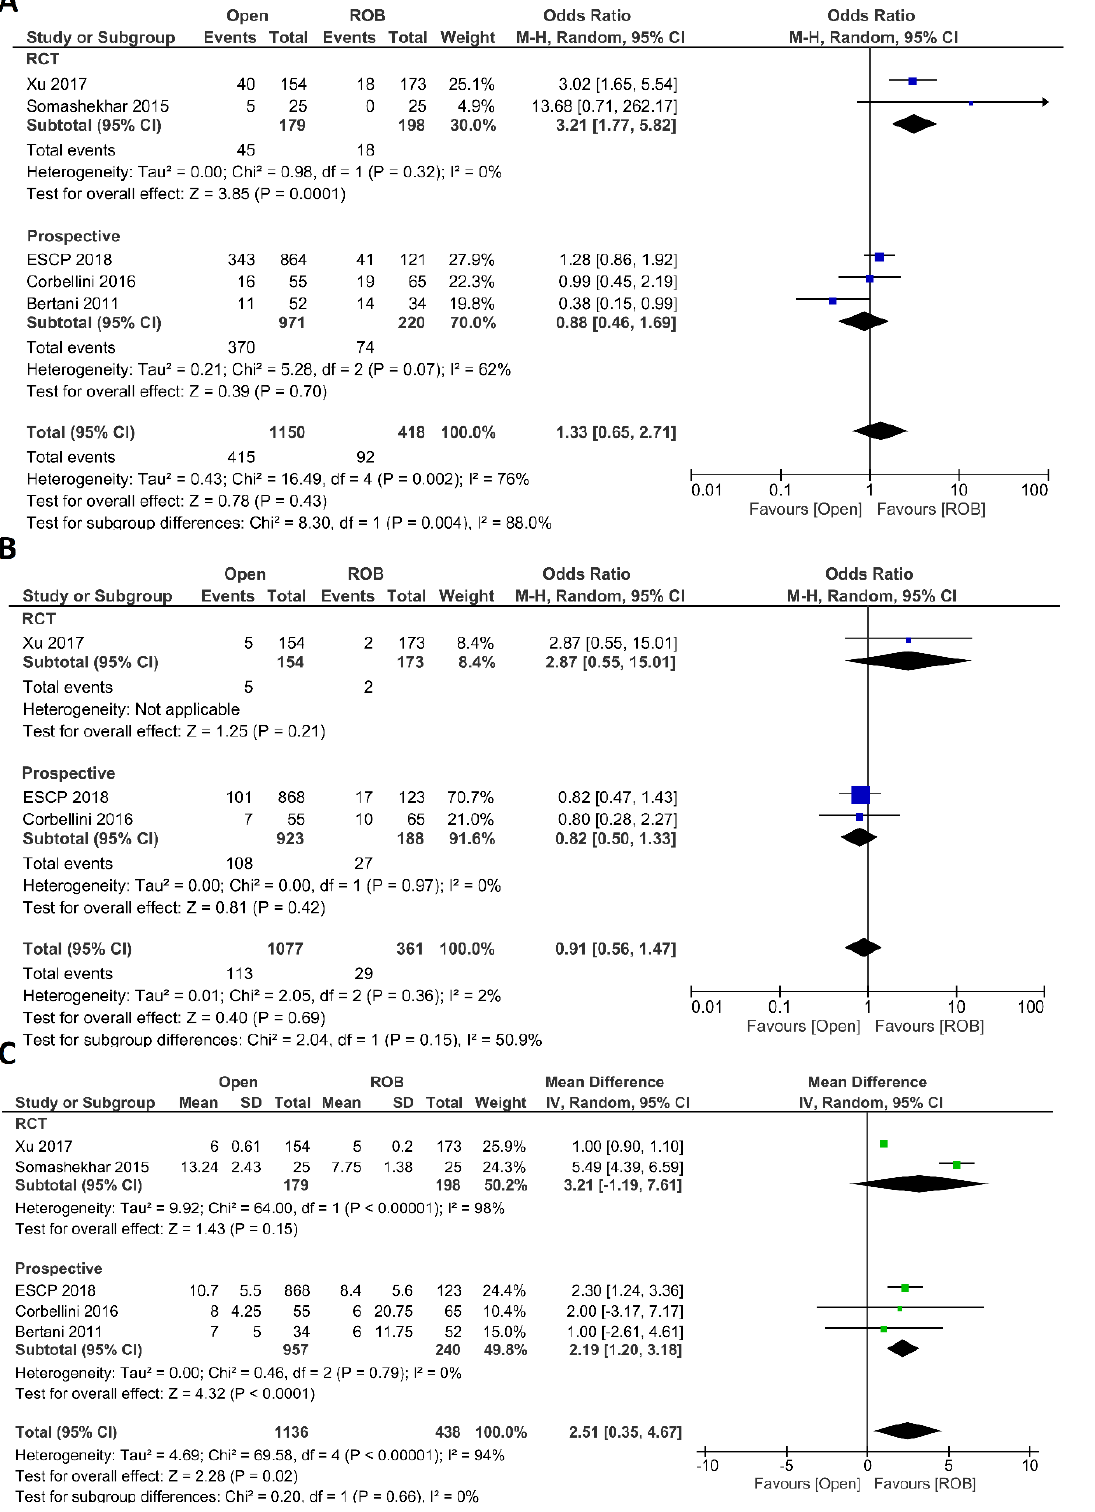
Figure 4. Forest plots comparing ( A ) postoperative complications [18,20,40,44,46], ( B ) major compli- cations [18,40,44], and ( C ) length of hospital stay [18,20,40,44,46] between robotic and open rectal resection (blue boxes representing odd ratios, green boxes representing mean differences, arrows representing 95% confidence intervals, and diamonds representing point estimates of pooled odd ratios or mean differences).